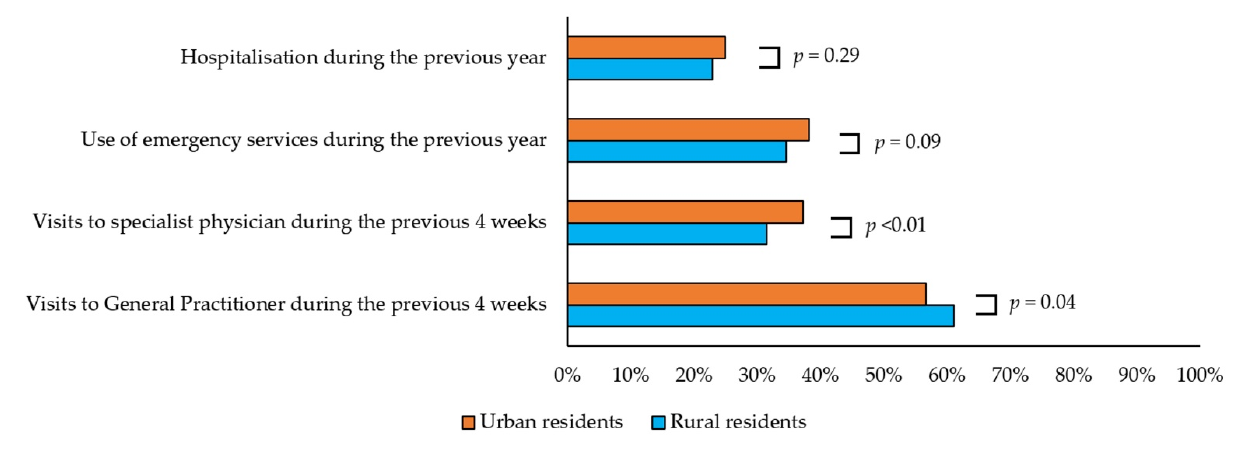
Figure 1. Use of healthcare resources by cancer patients, according to place of residence.